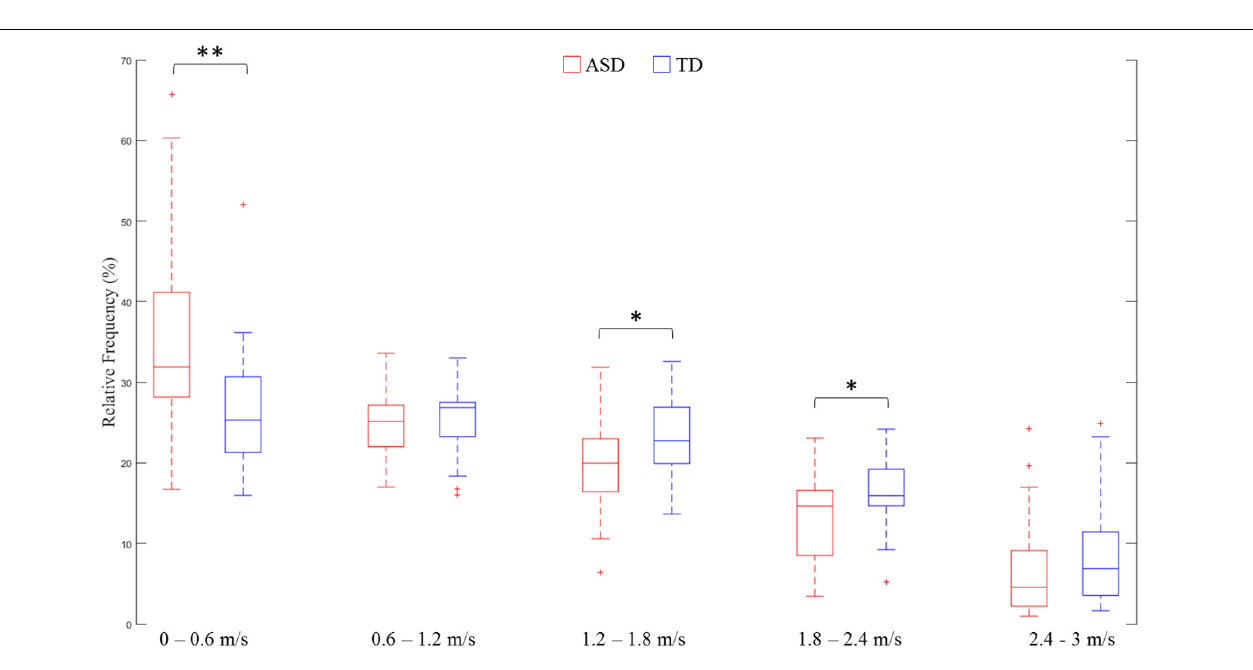
Frontiers in Human Neuroscience |